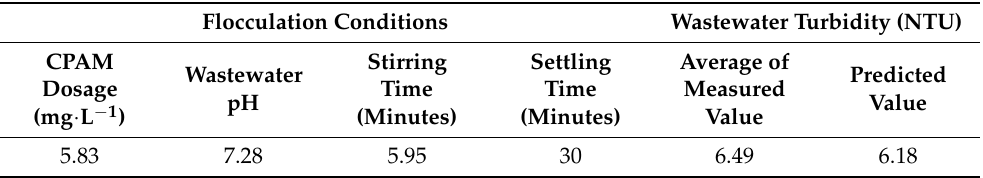
Table 5. Measured and predicted values of wastewater